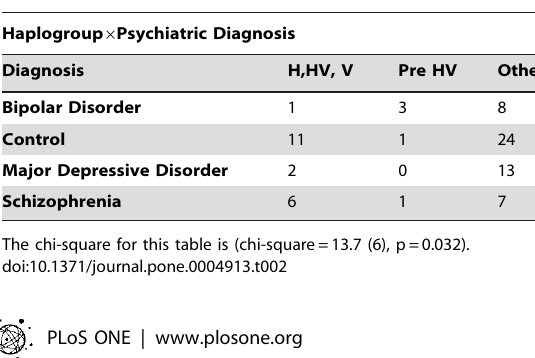
Table 2. The haplogroup determination of mtDNA derived from DLPFC was condensed from Table 1 and showed that BD and SZ were over-represented in Pre HV haplogroup and MDD was over-represented in the ‘‘other’’ haplogroups.